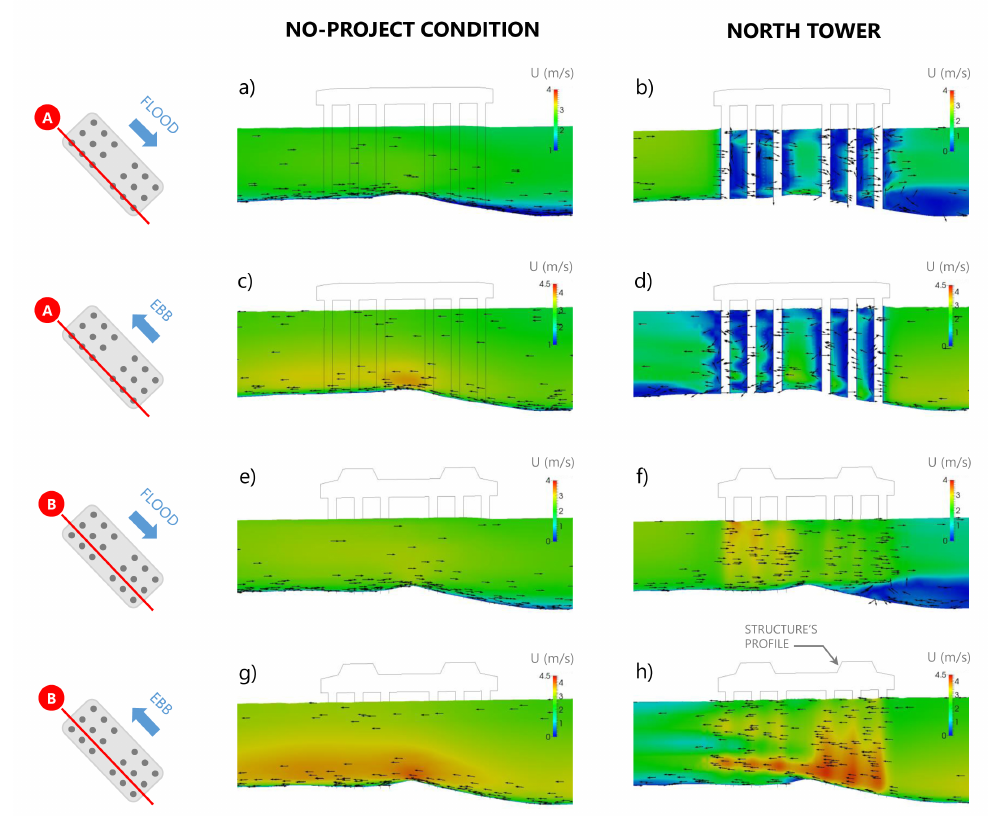
Figure 7. Side views of velocity fields at a vertical plane (A) coinciding with the southern-most line of piles in the North Tower site for the flood-tide ( a , b ) and ebb tide- scenarios ( c , d ) in the no-project condition and with the structure, respectively. Similar results at a vertical plane (B) between the southern-most and the immediate interior lines of piles for the flood-tide ( e , f ) and ebb tide- scenarios ( g , h ) in the no-project condition and with the structure, respectively. Arrows show the local flow direction and black lines delineate the structure’s